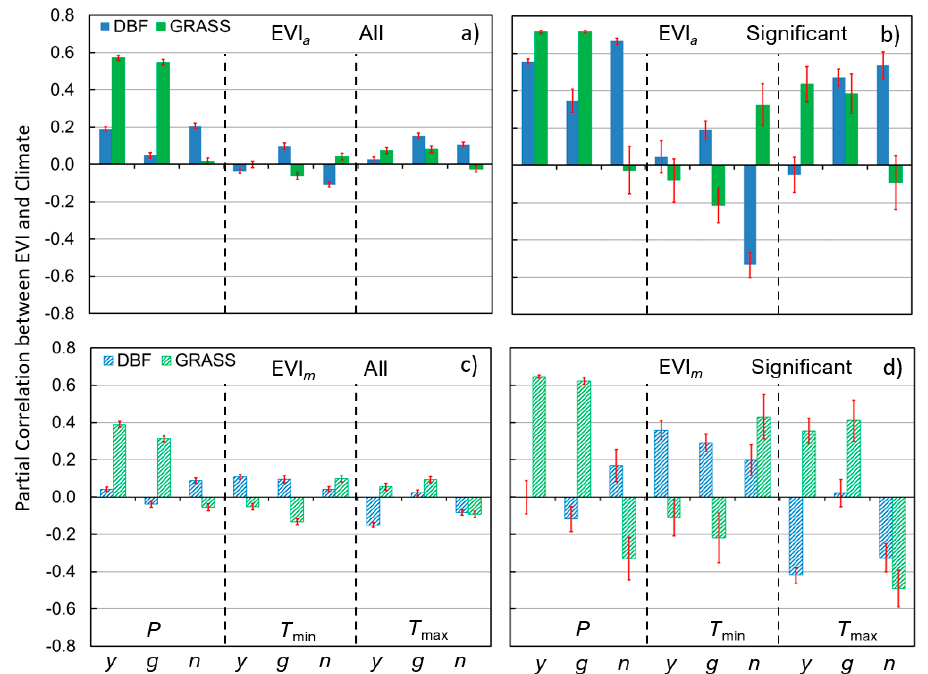
Figure 6. Partial Correlation between EVI and climate variables in 2001–2015 for the grassland (GRASS) and deciduous-broadleaved forest (DBF) patches. EVI a and EVI m indicate averaged and maximum EVI during growing season, respectively; P , T min , T max indicate precipitation, minimax, and maximum temperatures, respectively; y, g, and n indicate wet year, growing season, and nongrowing season, respectively. Panels ( a ) and ( c ) summarize all partial correlations; panels ( b ) and ( d ) summarize the significant partial correlations, i.e., significantly lower than 0 or significantly greater than 0 ( p < 0.05, one-tail test).